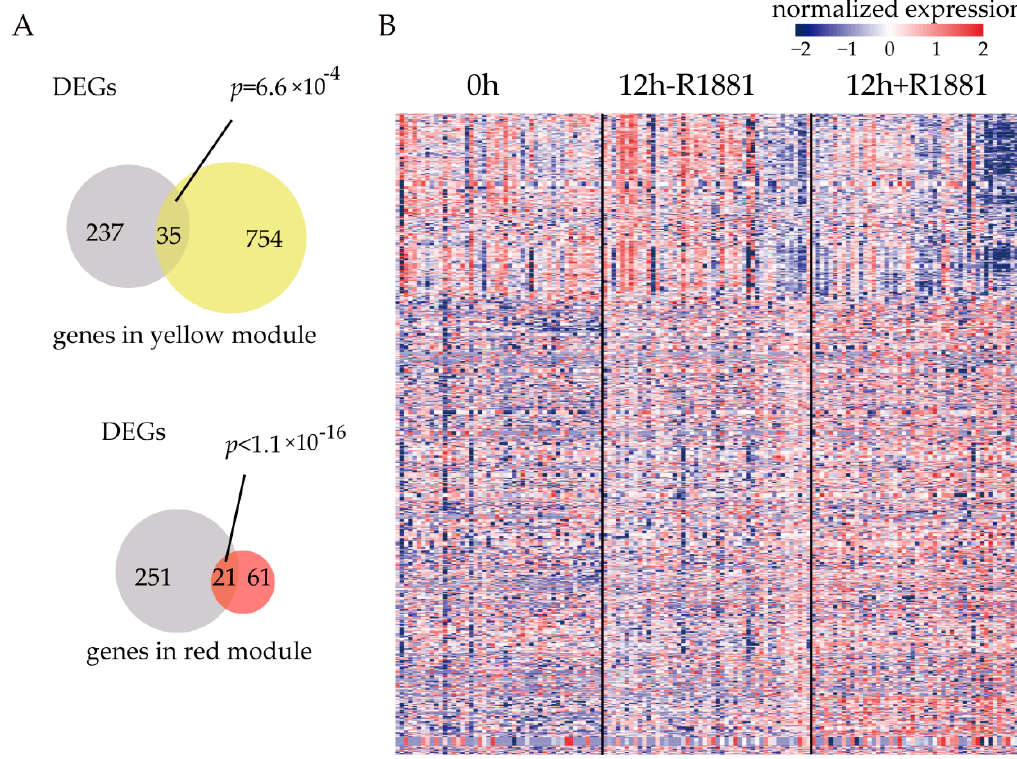
Figure 3. Gene modules significantly regulated by androgen receptor. ( A ) The yellow and red modules significantly overlapped with differentially expressed genes (DEGs) between 12 h + R1881 vs 12 h—R1881 from GSE99795. ( B ) The expression heatmap of genes in the yellow and red module.